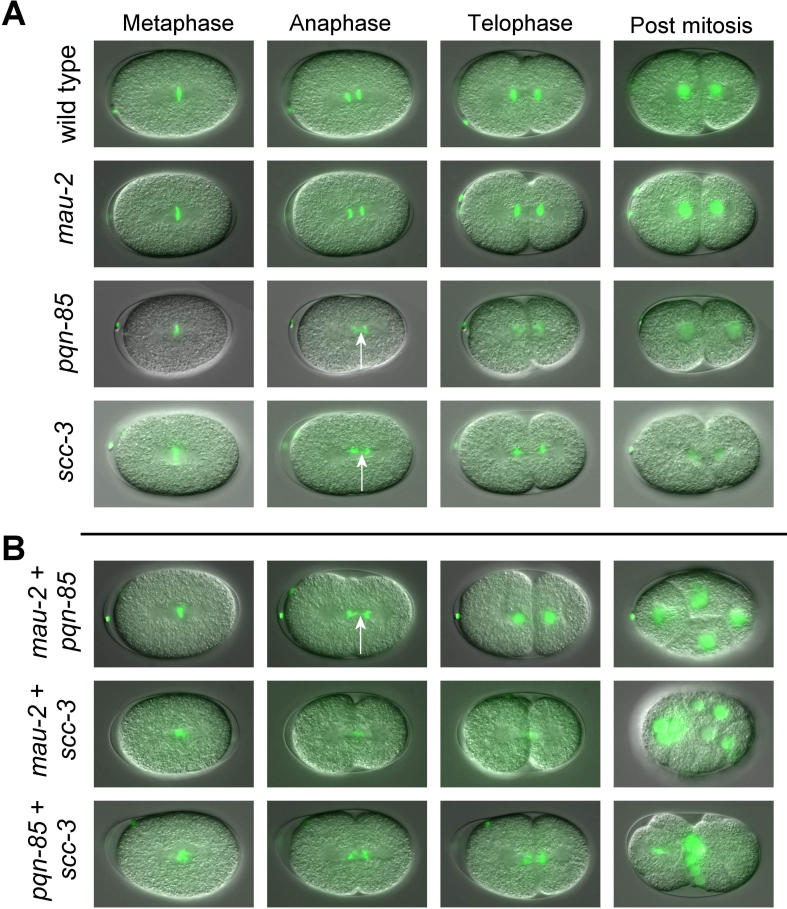
MAU-2 and PQN-85 Regulate Chromosome Segregation in Early
C. elegans Embryos
(A) Individual RNAi knockdowns. Chromosome-segregation defects are not obvious in the progeny of
histone::GFP hermaphrodites injected with double-stranded
mau-2 RNA. However, lagging anaphase chromosomes were evident in the case of
pqn-85(RNAi) and
scc-3(RNAi) embryos (white arrows).
(B) Double RNAi knockdowns. Early
mau-2 +
pqn-85 (RNAi) embryos showed chromosome lagging (white arrow) where some ensuing cells appear to be unaffected and others have multiple and misshapen nuclei (right image). Early
mau-2 +
scc-3 (RNAi) and
pqn-85 +
scc-3 (RNAi) embryos consistently showed severe chromosome segregation defects where the DNA does not appear to move to either pole. This results in the phenotype in which all cells either have multiple nuclei or have none at all. Precise assignment of cell-cycle stages was not possible because of the severity of the chromosomal phenotype.